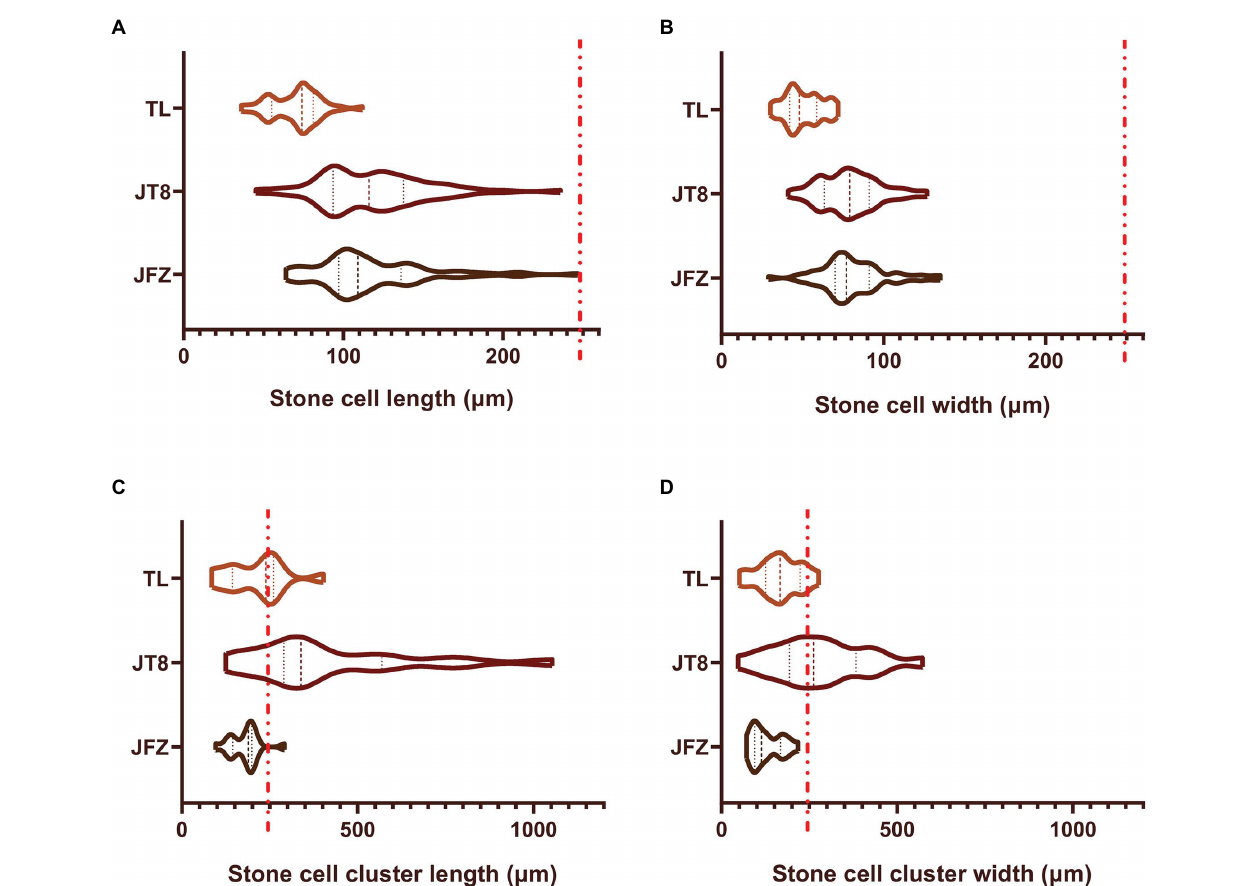
FIGURE 4 | The sizes of stone cells and stone cell clusters in freezing microtome sections of fruit pulp collected at 126 DAF from three loquat plants as determined through phloroglucinol-HCl staining and microscopic observation. Violin plots are used to display the distribution of data sets, and similar violin shapes represent similar data distributions. The thick dashed lines represent the median values, and the two thin dashed lines represent the first and third quartiles. The wider parts of the violin parts correspond to higher probabilities of observed values, while the narrower parts correspond to lower probabilities. Longer and sharper ends of the violin plots correspond with more outliers. The red-dashed line indicates 250 μ m. (A) Stone cell length; (B) Stone cell width; (C) Stone cell cluster length; (D) Stone cell cluster